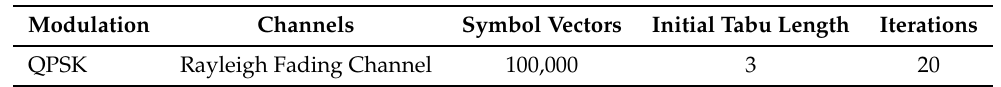
Table 3. Simulation